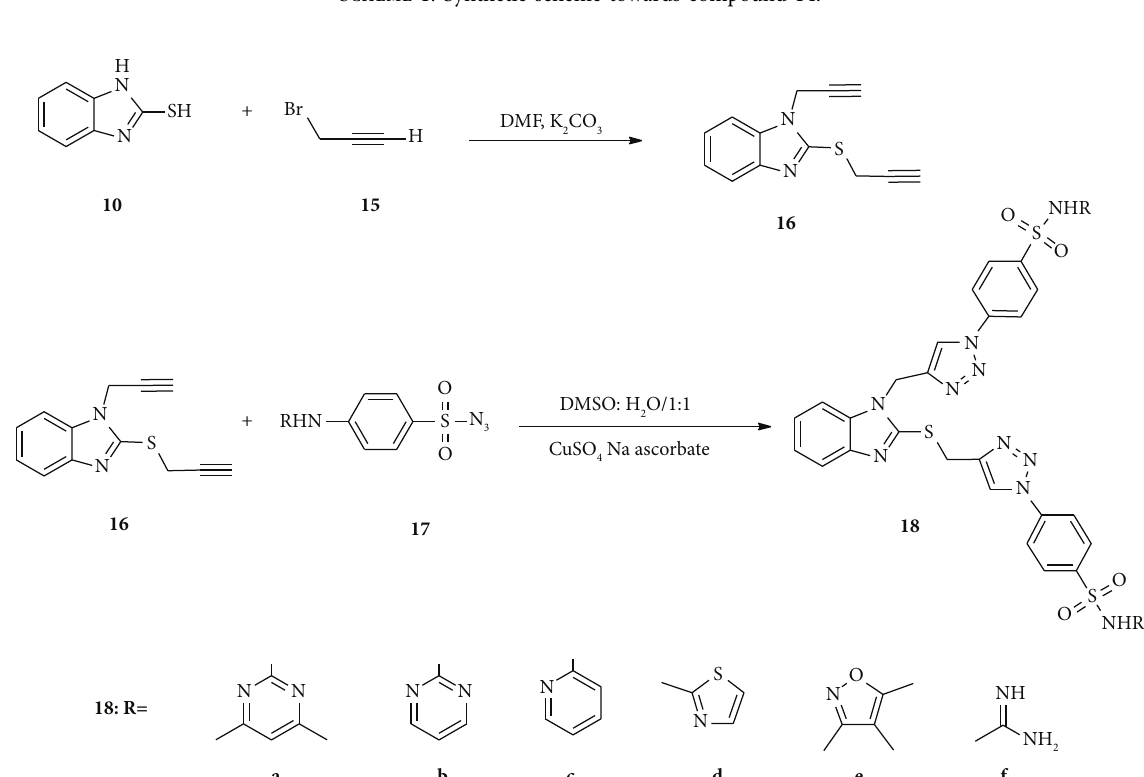
Scheme 1: Synthetic scheme towards compound 14.